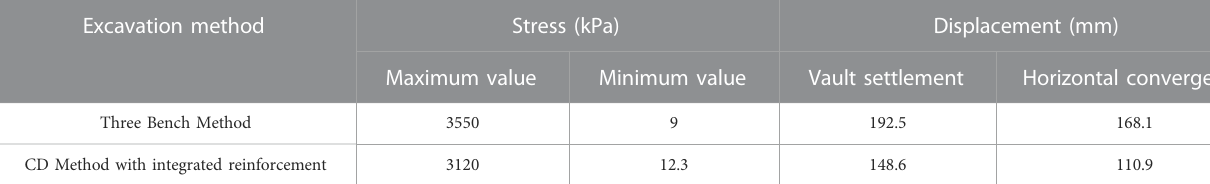
TABLE 3 Comparison of surrounding rock stress and deformation.